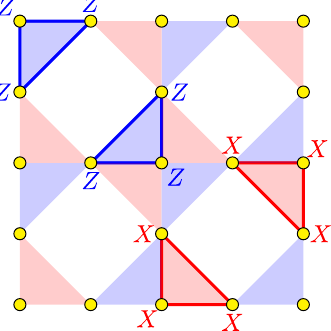
FIG. 3. The subsystem toric code of Ref. [34]. Data qubits (yellow-filled circles) are placed in the middle of each edge and on each vertex of a square lattice of the toric code. Opposite sides are identified. The gauge group is generated by three-qubit triangle operators . The two Z triangle operators in the top left face are outlined with a blue border, and their product forms a six- qubit Z stabilizer. Similarly, in the bottom right face, two X triangle operators are outlined with a red border, and their product is a six-qubit X